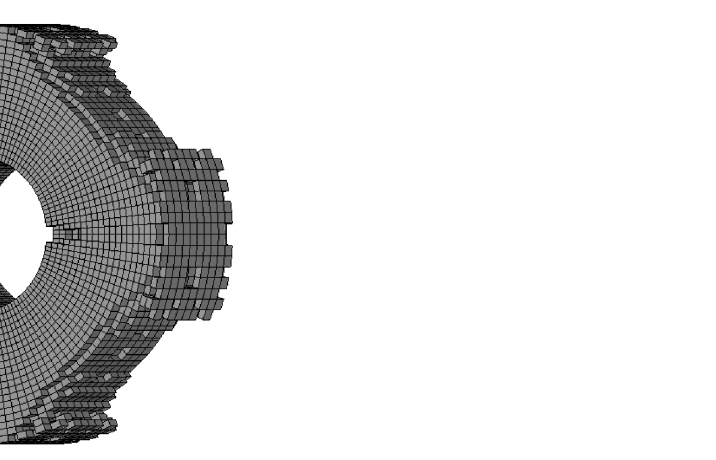
Figure 15. An example on topology optimization of a rotor core for a switched reluctance motor [78].